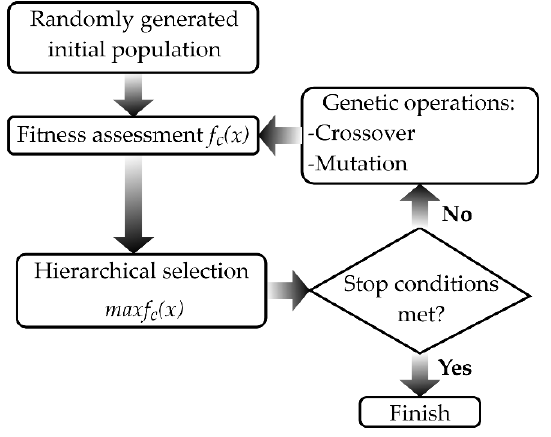
Figure 1. Flow chart for the implementation of a GA.